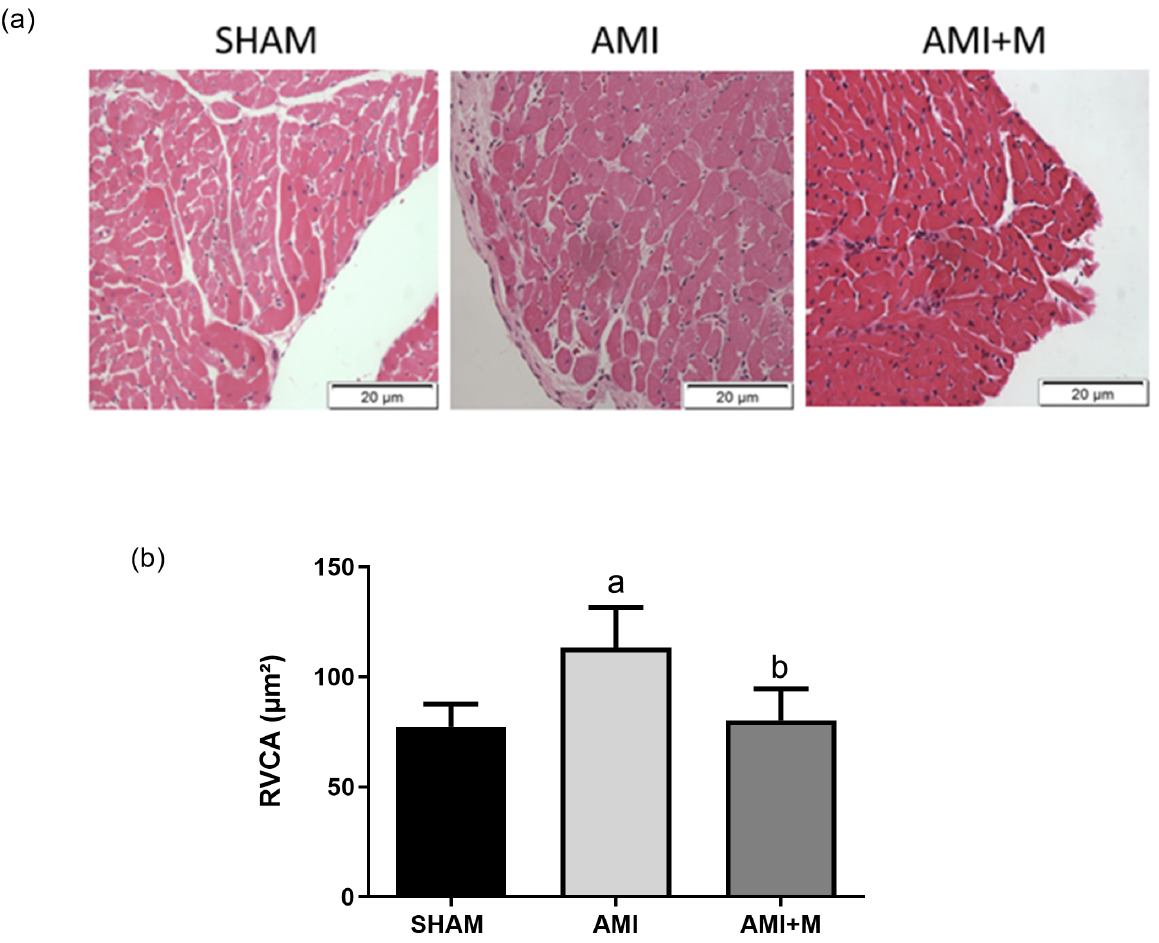
Figure 3. (a) Illustration of right ventricular histology, cross section at 200x magnification and staining of hematoxicillin and eosin (HE). (b) Quantification of right ventricular cardiomyocytes area (RVCA, µm 2 ). Results are expressed as mean ± SD from 7 to 8 animals per group. a p<0.05 as compared to SHAM. b p<0.05 as compared to